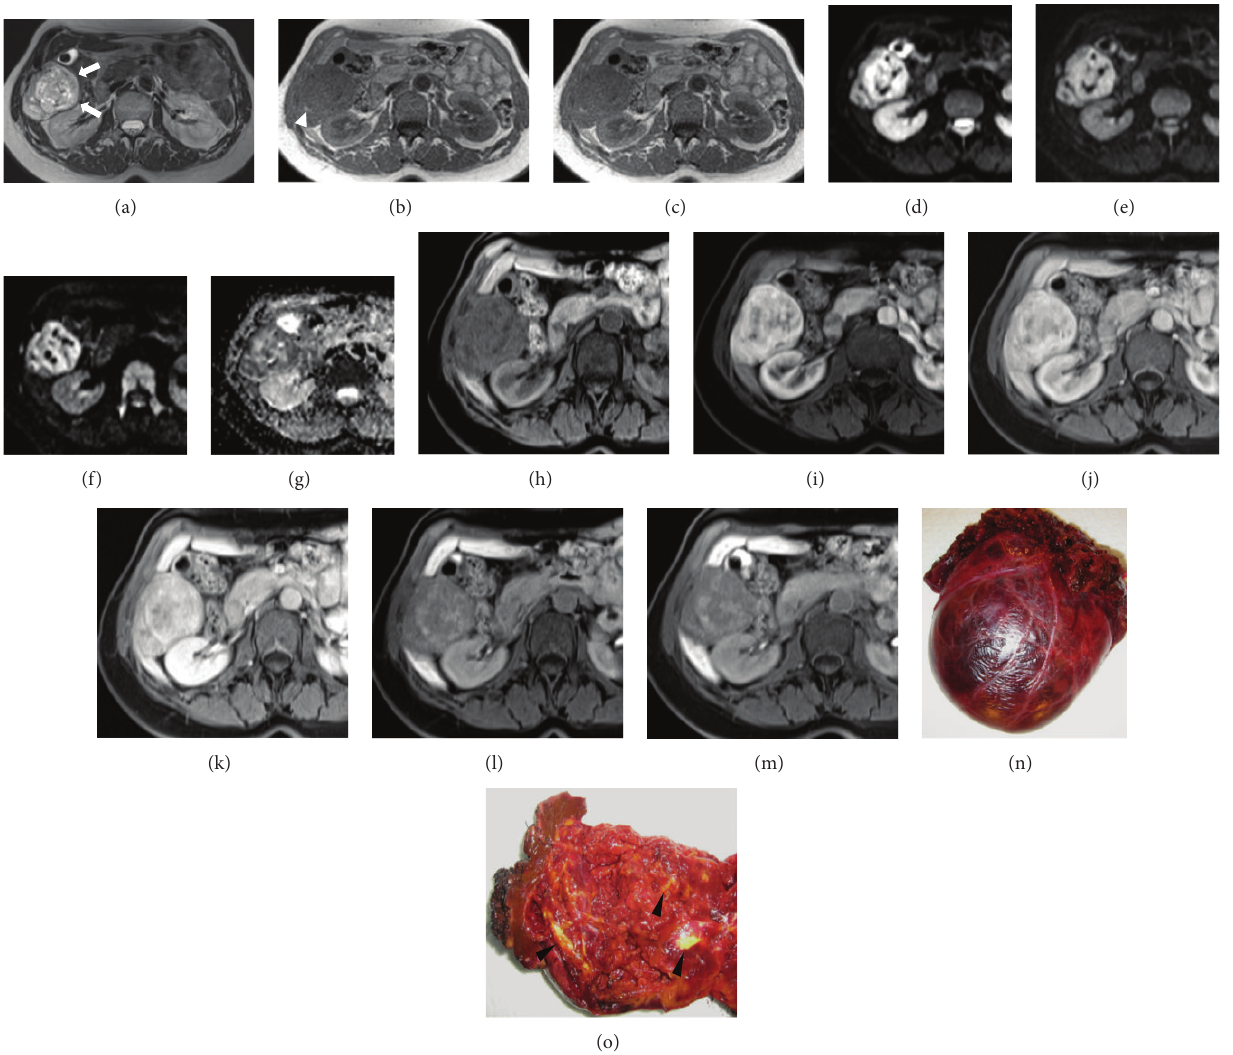
Figure 5: 𝛽 -catenin-mutated adenoma. (a) In S VI heterogeneous well delineated hyperintense lesion (arrows). (b-c) T1w in- and out- phased images. The mass is slightly hypointense relative to hepatic parenchyma with focal signal drop due to intralesional fatty infiltration (arrowhead). (d–g) DWI sequences. The lesion increases signal intensity from 50 (d) to 400 (e) and to 800 (f) b values. In ADC map (g) the nodule shows heterogeneous signal. (h–l) In dynamic evaluation after Gd-EOB-DTPA administration the mass shows intense heterogeneous enhancement in arterial phase (i) without evident wash out in portal (j) and (k) equilibrium phases. (l-m) In hepatobiliary phases after 10 󸀠 (l) and 20 󸀠 (m), the lesions are heterogeneous hypointense relative to the adjacent liver parenchyma. (n-o) Gross specimen confirms capsulated heterogeneous mass with fatty component